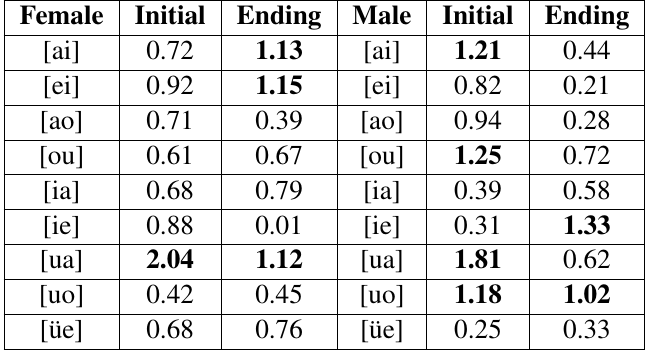
Table 2 Euclidean distance between the primary level learner and the standard speaker.